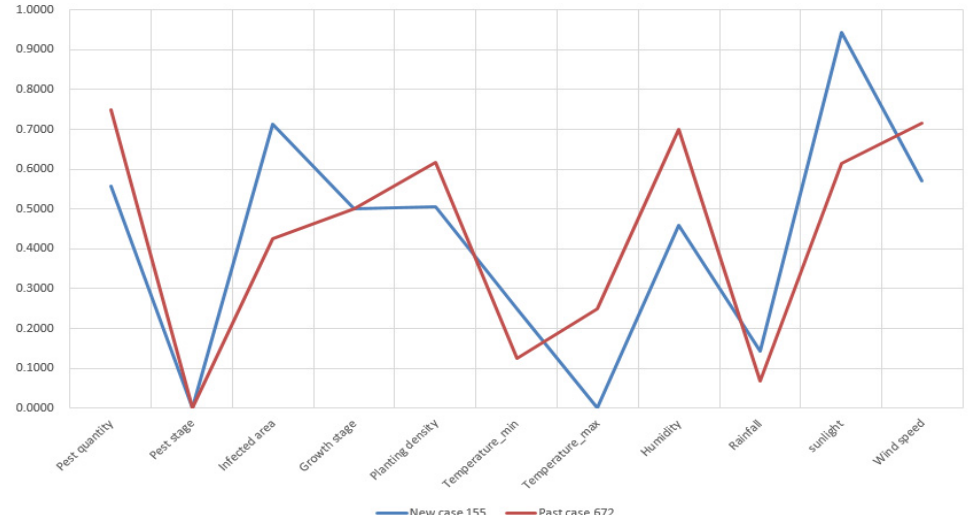
Figure A9. Attribute visualization of new case 154 and retrieved case 580.